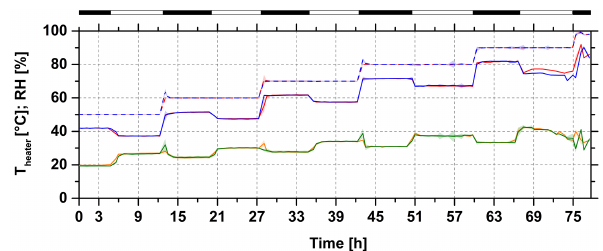
Figure 6. Relative humidity controlled by ATRAHS at different lev- els from 50 to 100%. Straight red line: RH cuv of the reference cu- vette; straight blue line: RH cuv of the sample cuvette; dotted red line: RH in of the reference cuvette; dotted blue line: RH in of the sample cuvette; orange line: T heater of the reference humidifier; green line: T heater of the sample humidifier. The diurnal cycle of light was simulated by a climate cabinet with 6h light period (white balk) and 6h dark period (black